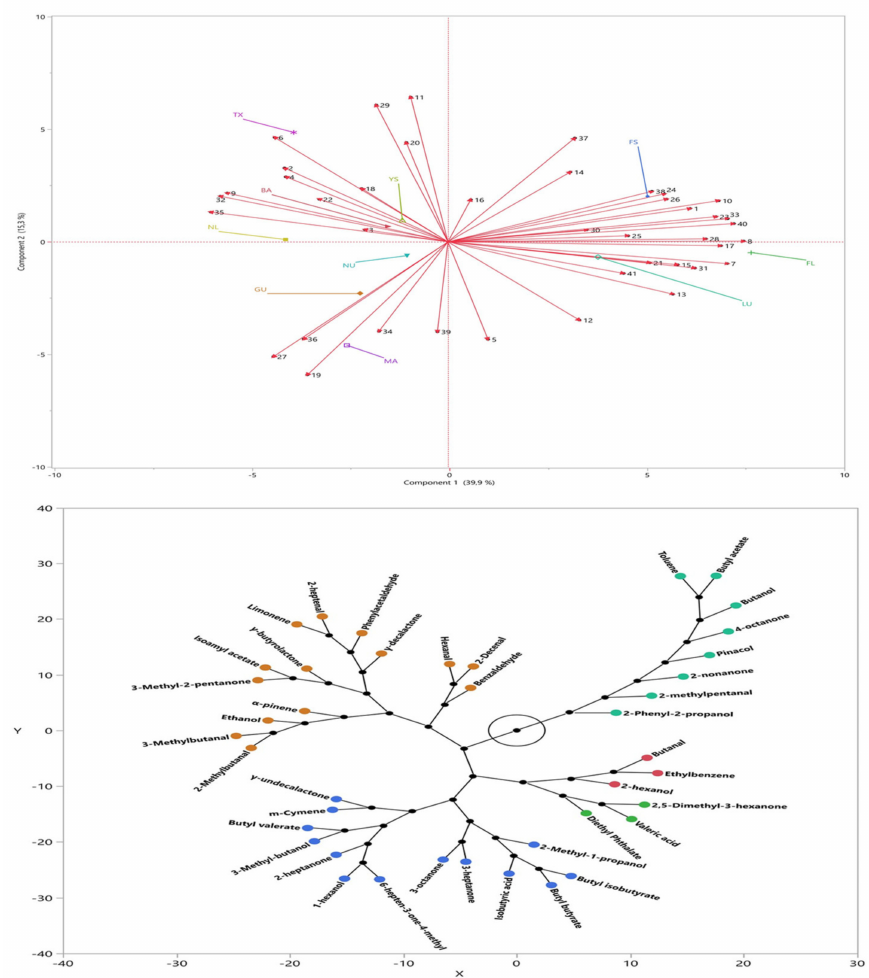
Figure 2. Factor loadings ( top ) and cluster ( bottom ) of the volatile compounds for almond